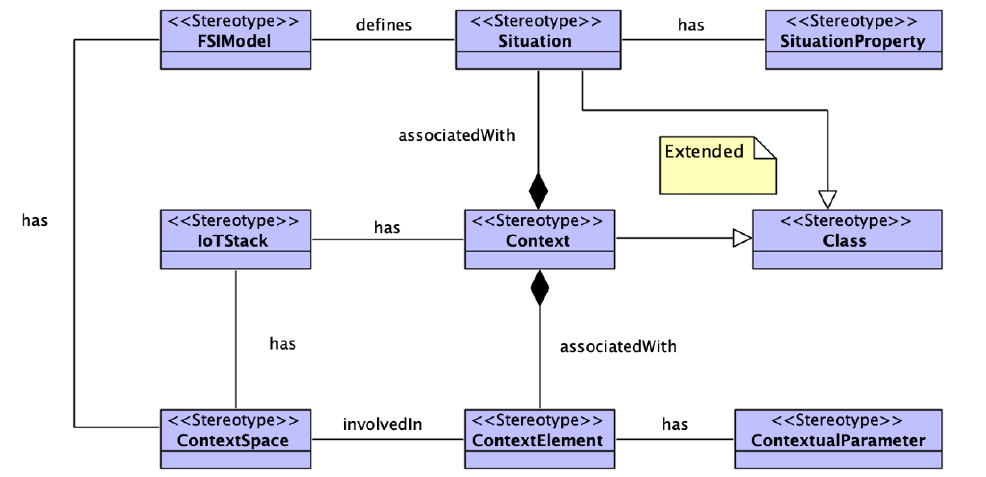
Figure 3. Extended class